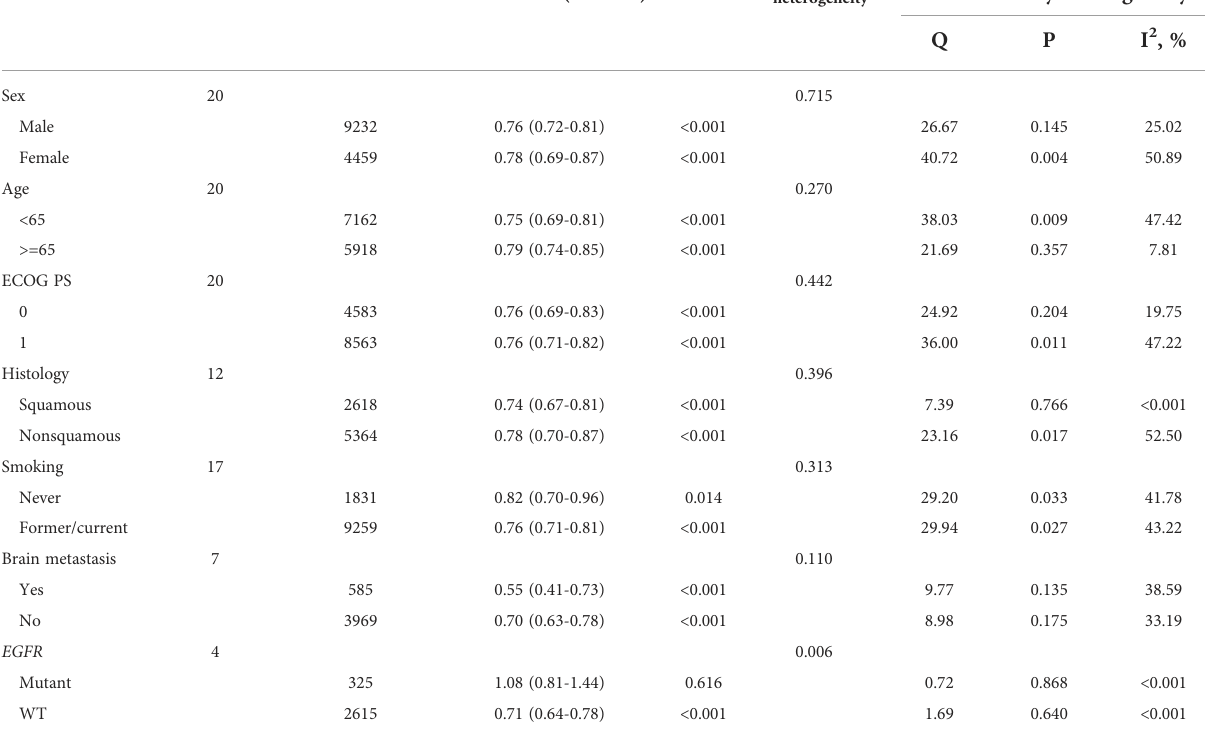
TABLE 2 Differences in ef fi cacy of IO vs control therapies by subgroups. Variable Studies No.